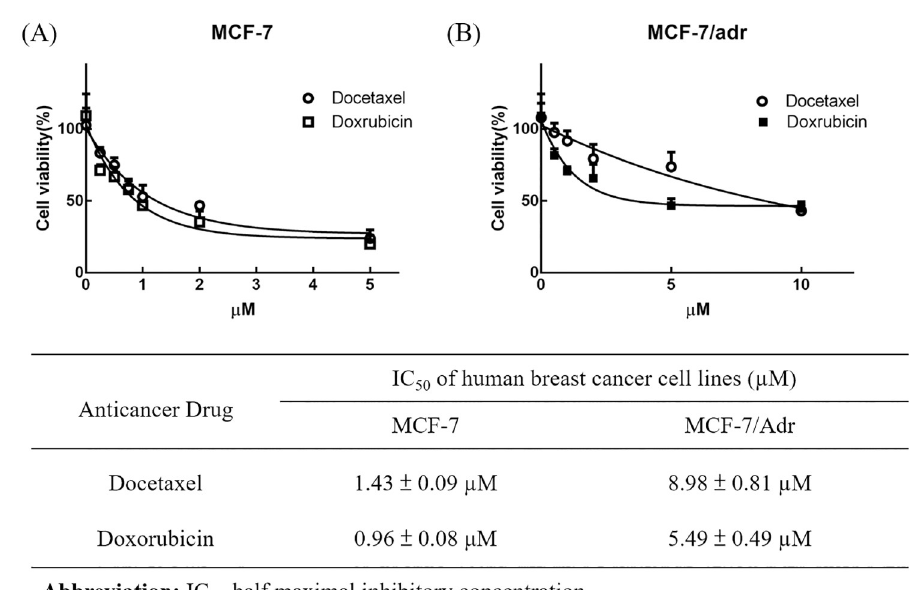
Fig 3. Inhibition of DOX or DTX on proliferation of (A) MCF-7 and (B) MCF-7/Adr cells. The IC 50 values of DOX or DTX were calculated and showed on table. Data were shown by mean ± SD, n = 3. https://doi.org/10.1371/journal.pone.0260533.g003 MCF-7/Adr images showed that the fluorescence signal of the DOX was found in the outer part of nucleus and cytoplasm because of the action of the drug efflux pump; however, the DOX fluorescence signal of DOX/TG1 treatment was detected in the cell nucleus, indicating good internalization by TG1.